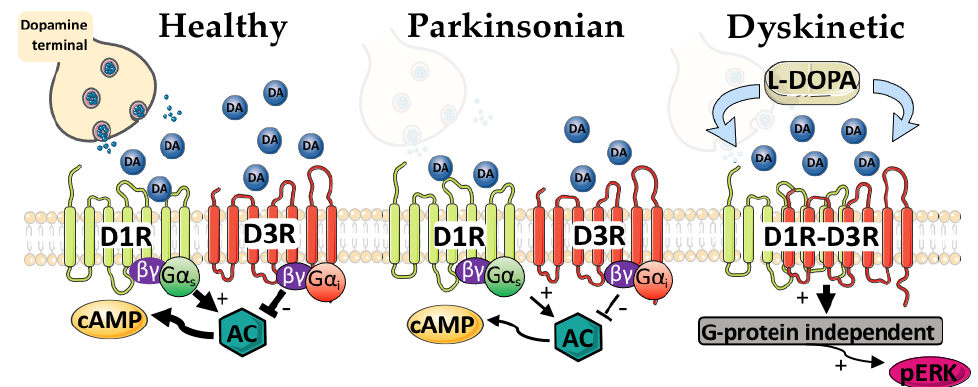
Figure 2. Theoretical signaling pathways of the dopamine D1/D3 receptors in the healthy, Parkinsonian or dyskinetic striatum. In the intact brain, dopamine (DA) is released from striatonigral terminals and interacts with post-synaptic D1 receptors (D1R; low DA affinity but high expression) and dopamine D3 receptors (D3R; high DA affinity but low expression) which couple with canonical G-proteins to increase or decrease G-protein signaling, respectively. Each of these receptor properties is theoretically maintained in PD, with reductions in DA levels due to the retraction of striatonigral terminals. D1R is sensitized due to increased presence at the membrane. In the dyskinetic state, DA is exogenously provided via L-DOPA. D3R is upregulated and interacts with D1R, potentially in the form of a heteromer. D1R–D3R cooperate to drive downstream signaling, such as phosphorylation of ERK (pERK). This signaling might be G-protein-independent. cAMP: cyclic AMP; AC: adenylyl cyclase. Image credit: Servier medical art (http://smart.servier.com/; Access date: 15 March